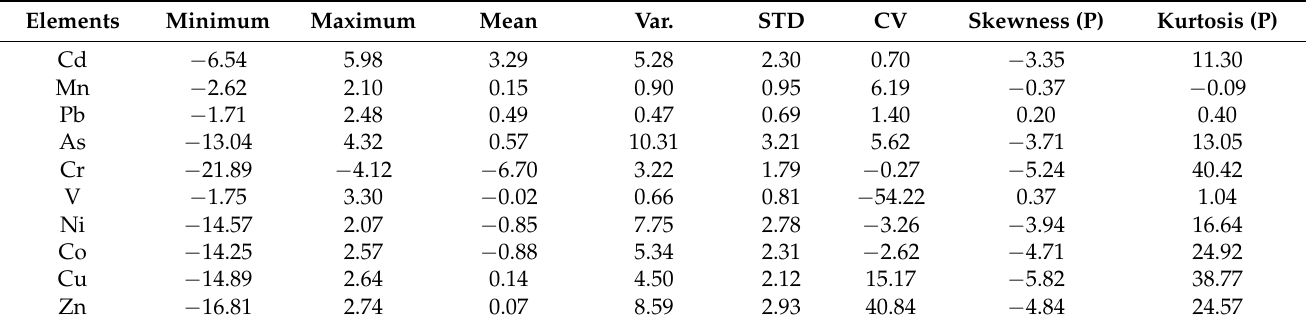
Table 7. Descriptive statistics of geo-accumulation index